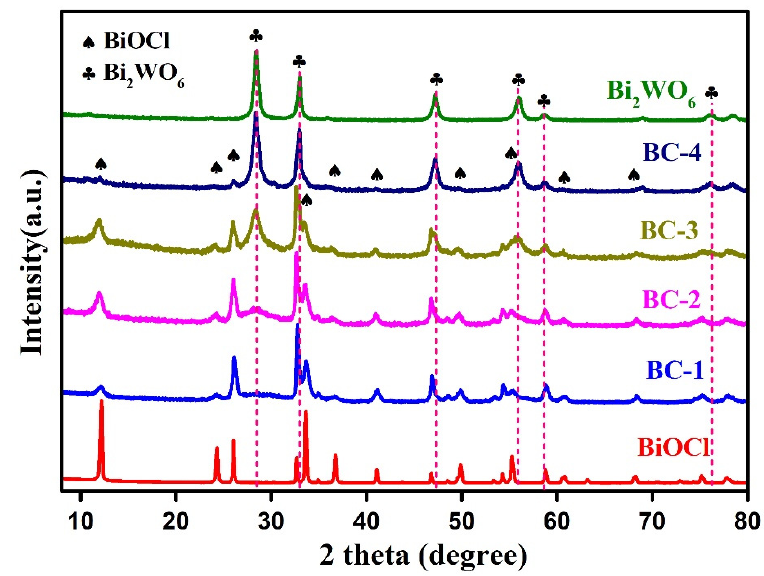
Figure 1. XRD patterns of BiOCl, Bi 2 WO 6 , and Bi 2 WO 6 /BiOCl nanocomposites.